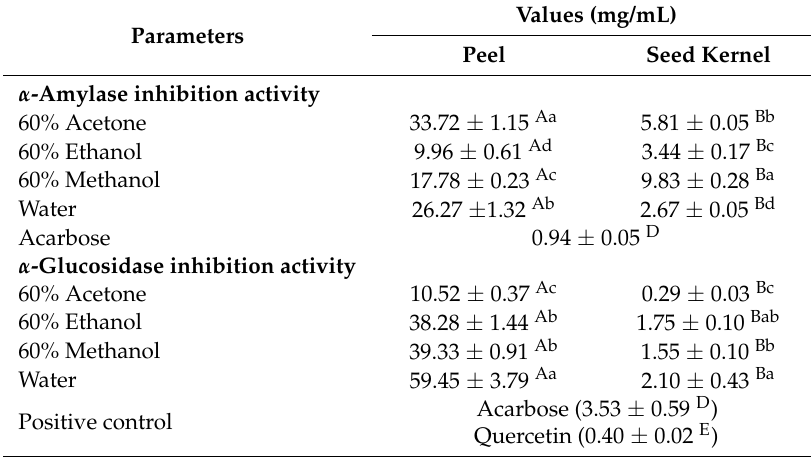
Table 3. In-vitro anti-diabetic activity of different solvent extracts of M. odorata peel and seed kernel.